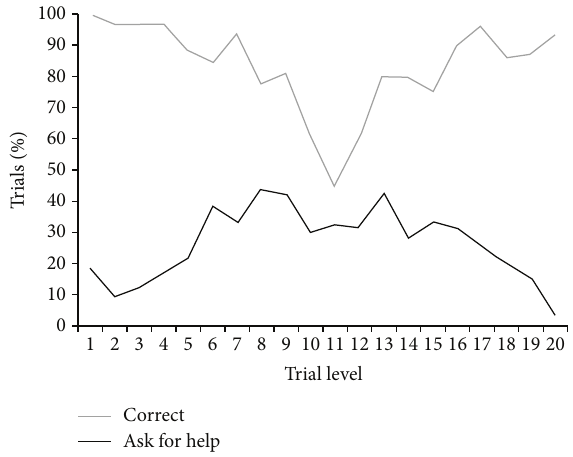
F 2: Overall performance (total the presents to the two mice and the overall percentage of trials at each level for which the children gave the present �rst to the Helper (the uncertainty